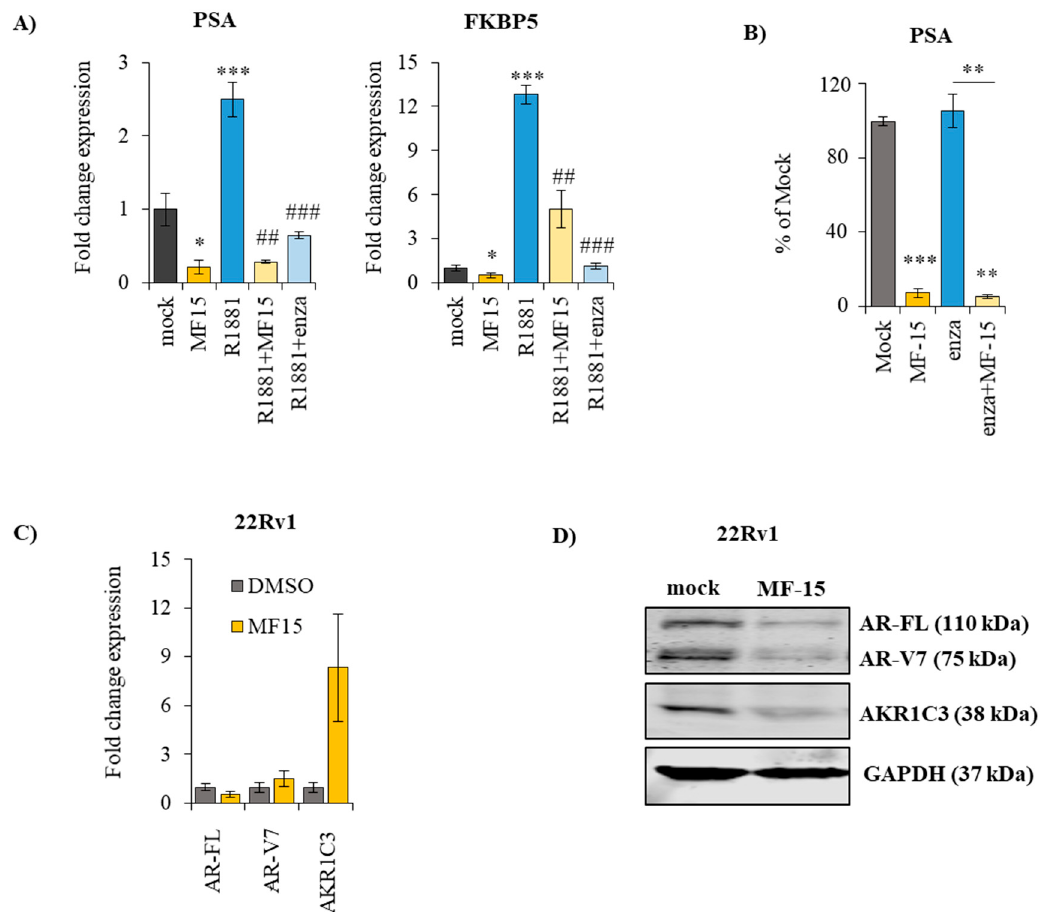
Figure 4. MF-15 reduces the expression of androgen-regulated genes, diminishes PSA production and decreases the expression of AR-FL and AR-V7 . ( A ) Expression of the androgen-regulated genes PSA and FKBP5 was determined with real-time qPCR following treatment of 22Rv1 cells with the indicated drugs over 3 days. After normalization to the housekeeping gene HMBS, fold change expression was calculated to the mock control for each individual experiment. ( B ) PSA levels were measured in the cell culture supernatant after treatment of 22Rv1 cells with 10 µM MF-15 on a Cobas 8000 instrument (Roche) and calculated as percentage of mock control (DMSO). ( C ) Expression of AR- FL, AR-V7, and AKR1C3 was assessed by real-time qPCR in 22Rv1 cells treated with MF-15 or DMSO over 3 days. Expression of each gene was normalized to HMBS and expressed as fold change to the mock control. ( D ) Western blot analysis of AR-FL, AR-V7 and AKR1C3 was performed as described under material and methods. Glyceraldehyde 3-phosphate dehydrogenase (GAPDH) was used